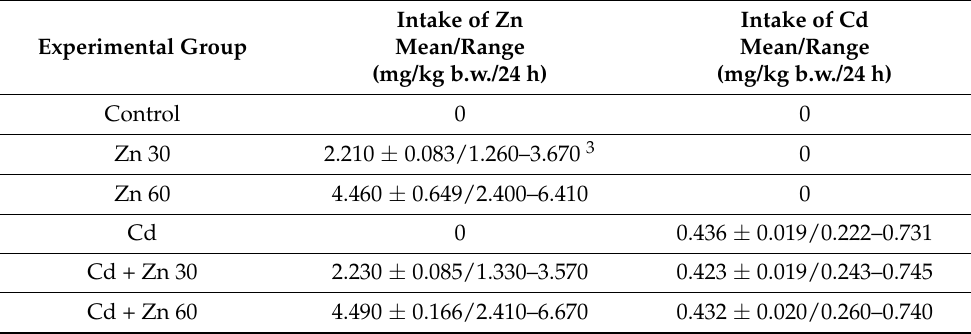
Table 1. Zinc (Zn) and cadmium (Cd) daily intakes via drinking water in particular experimen- tal groups 1,2